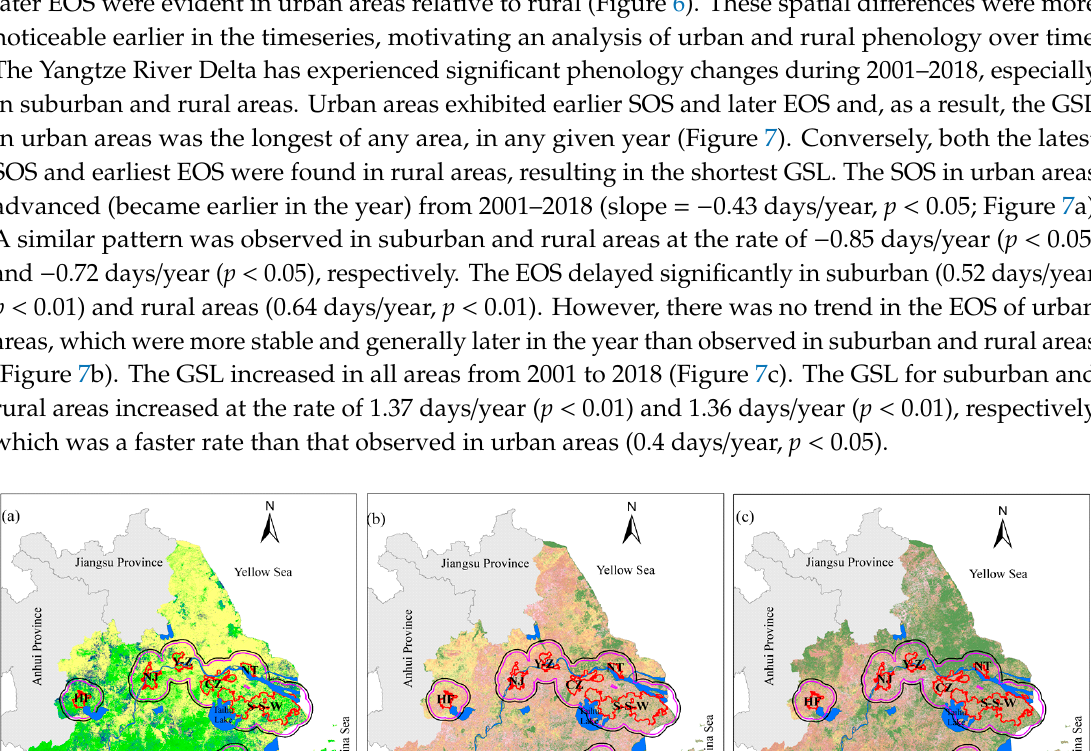
Figure 7. Inter-annual variations of ( a ) SOS, ( b ) EOS, ( c ) GSL in urban, suburban, and rural areas from 2001 to 2018. k values represent the slope of linear trends. In this analysis, the area defined as suburban is the combined area of all buffer areas between 0 and 20 km from the urban edge. 4.2. Phenology Changes along the Urbanization Gradient Phenology differences ( ∆ P) exhibited heterogeneities along an urban–rural gradient across years in the Yangtze River Delta (Figure 8). The SOS was earlier in urban compared with rural areas in 14 out of 18 years, ranging from − 22.3 days in 2006 to 0.3 days in 2003. Conversely, the EOS was later in urban zones (16 out of 18 years) with the differences ranging from 15 days to –0.9 days. On average, SOS advanced 9.6 days and EOS delayed 6.63 days across the urban–rural gradient. This is consistent with previous reports that the differences for SOS and EOS in urban centers relative to rural zones